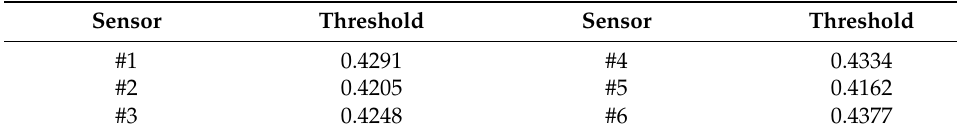
Table 4. Detection threshold of sensor.